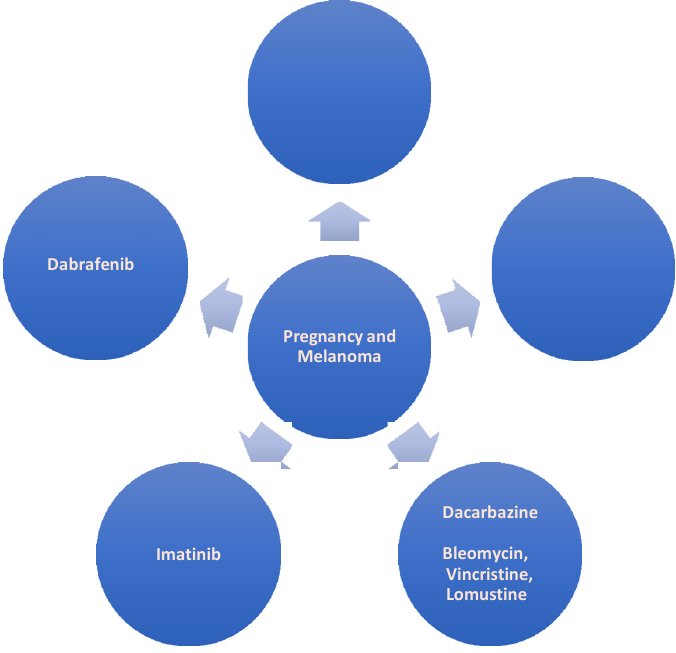
Figure 2. Pregnancy and Melanoma.